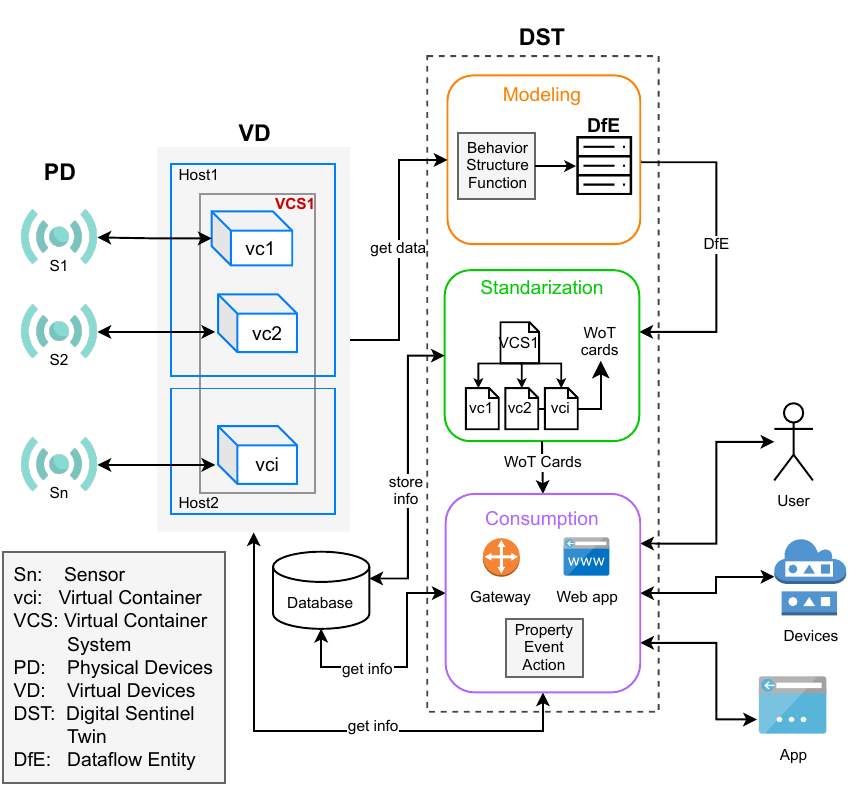
Figure 3. Context of a